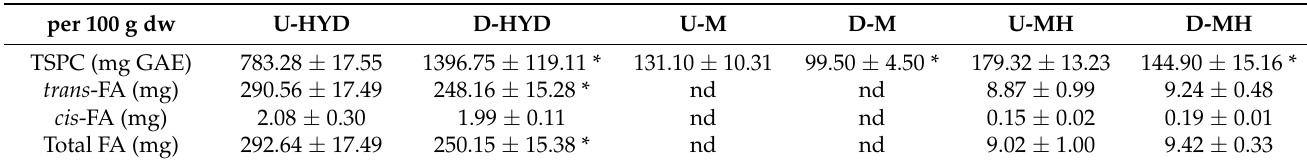
Table 2. TSPC and FA (free form) in HYD and mousses (M and MH) before (U) and after (D) simulated gastrointestinal digestion.